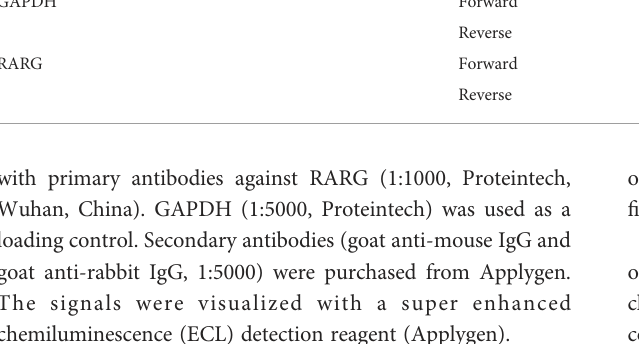
TABLE 2 Primers for qRT − PCR analysis. Gene